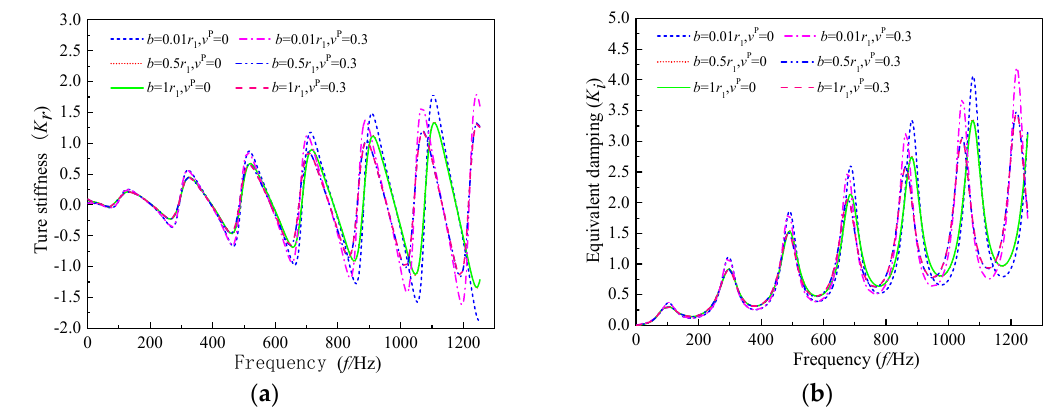
Figure 11. The e ff ect of the radius of strengthened soil due to a construction disturbance on the longitudinal impedance of a pile shaft: ( a ) true sti ff ness; ( b ) equivalent